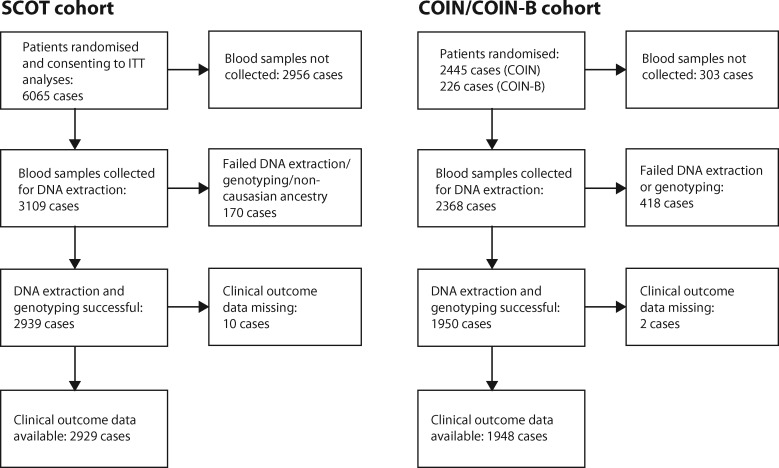
CONSORT diagram showing flow of patients analyzed in the study. ITT = intention to treat.